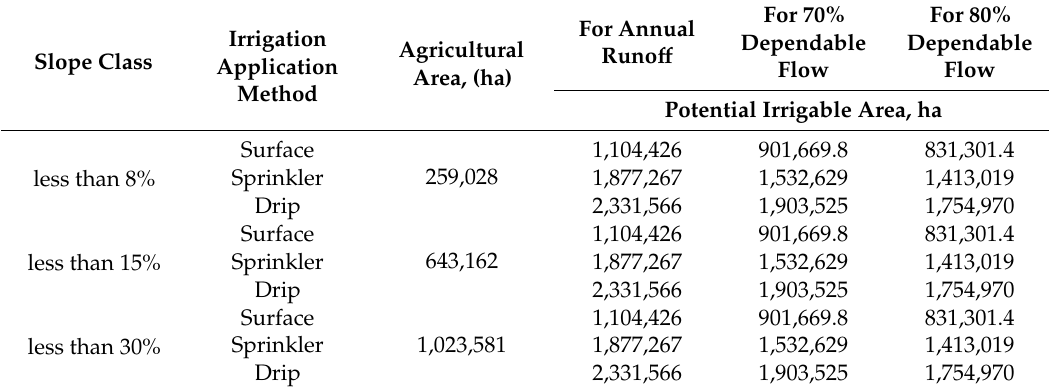
Table 5. Suitable land and potential irrigable areas in di ff erent scenarios.